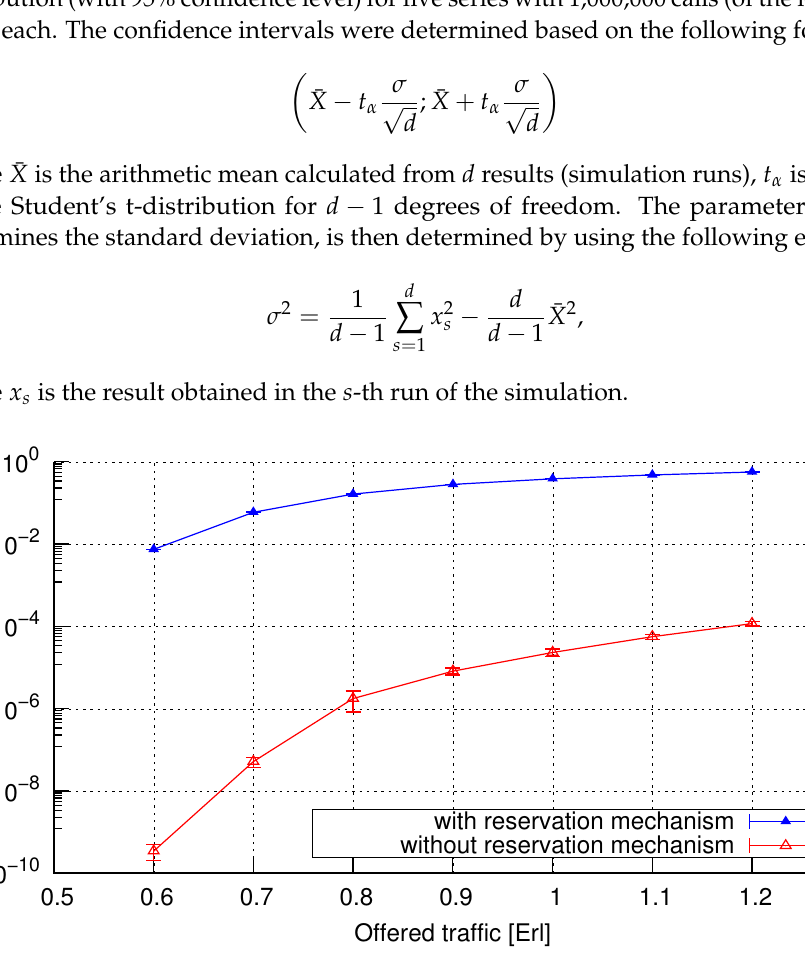
Figure 8. Loss probability for calls of class 1 (non-privileged class) in System 1.